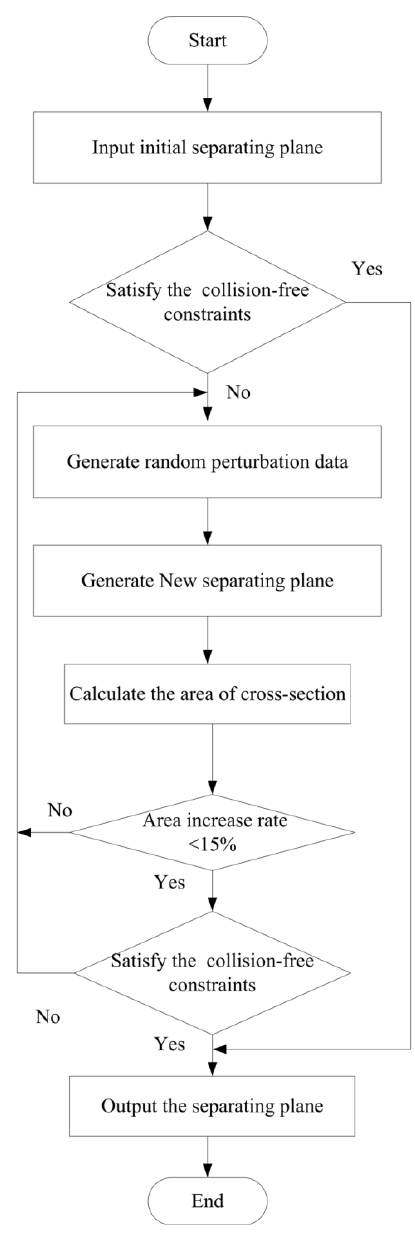
Figure 6. Process to determine the practicable separating plane.